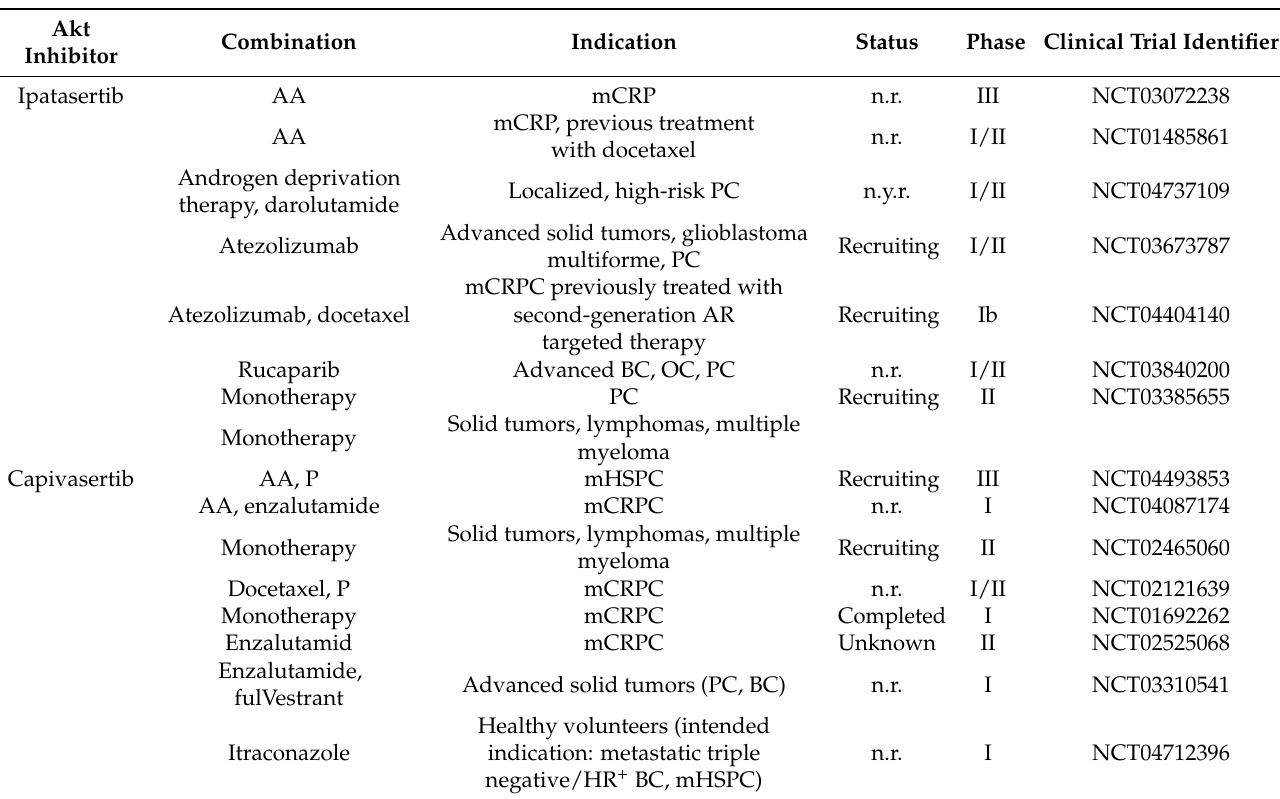
Table 2. List of clinical trials on protein kinase B inhibitors (Akt) in connection with prostate cancer treatment, posted in last ten years (2011–2021), data are from ref.